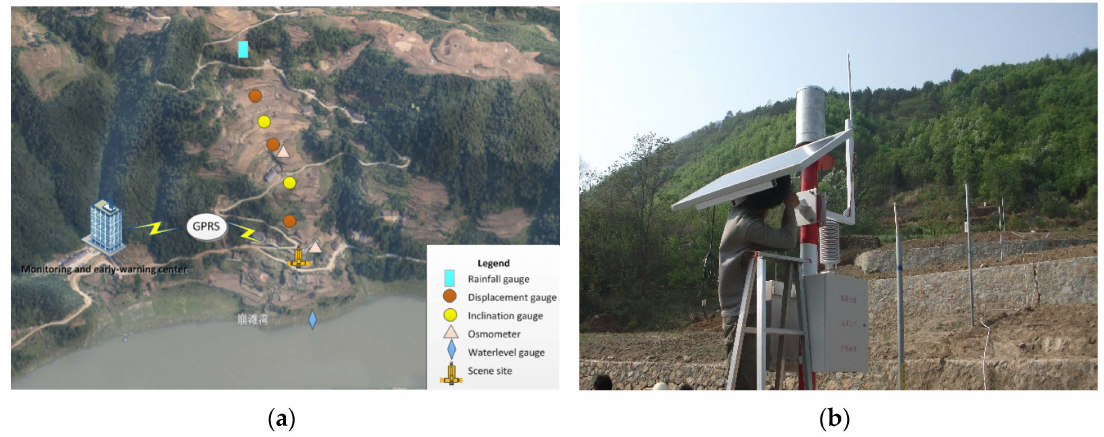
Figure 6. ( a ) The sensors network in one of the landslide; and ( b ) the deployment of